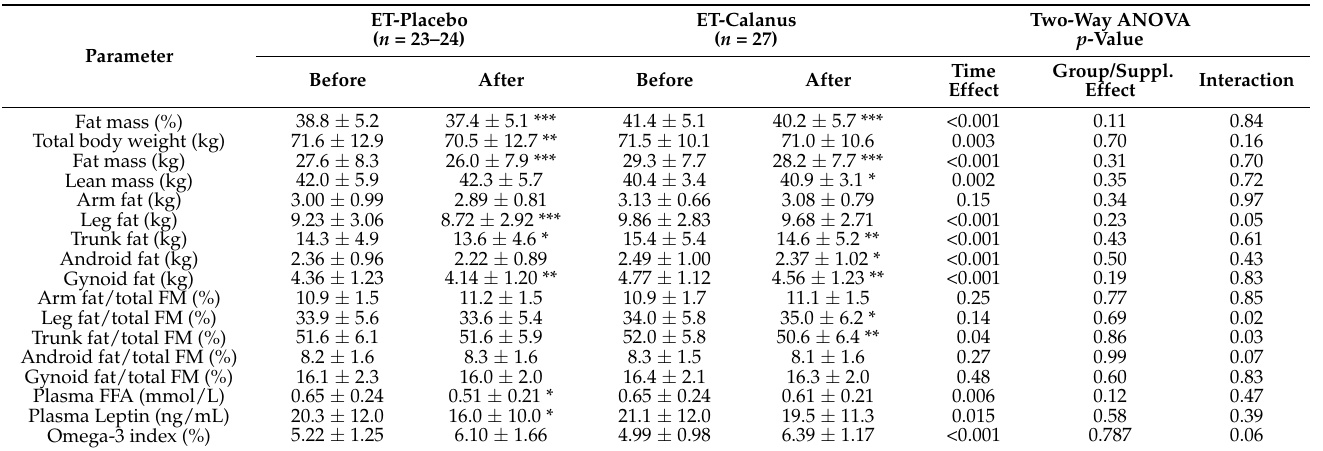
Table 3. Anthropometric characteristics, fat distribution, and circulating factors during the